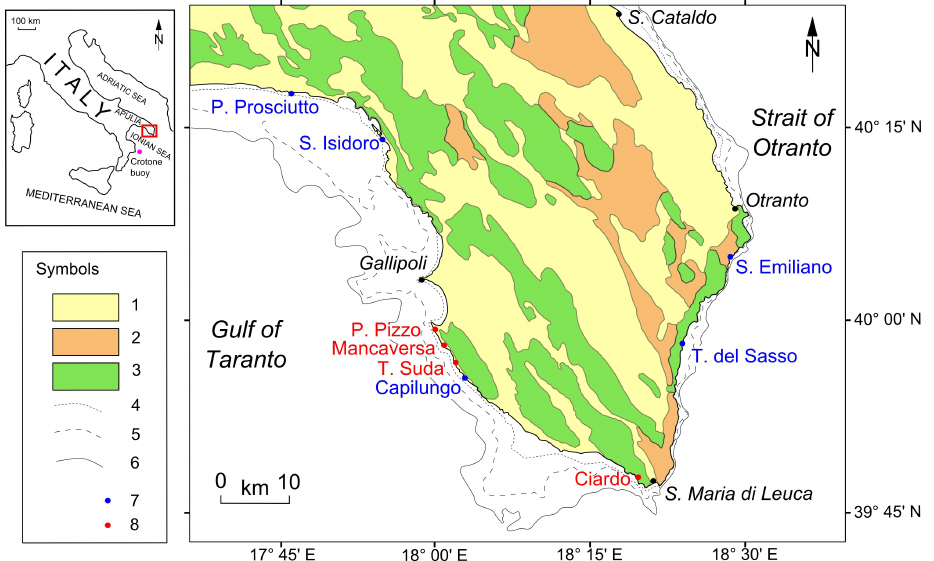
Figure 1. Simplified geological map of Southern Apulia: 1, Quaternary units (carbonates, marls, and bioclastic deposits); 2, Tertiary units (carbonates and marls); 3, Cretaceous units (limestones and dolostones). Other Symbols: 4, − 10 m isobath; 5, − 20 m isobath; 6, − 50 m isobath; 7, previously known site; 8, new site. Isobaths from the nautical chart of “Istituto Idrografico della Marina Militare” of Italy